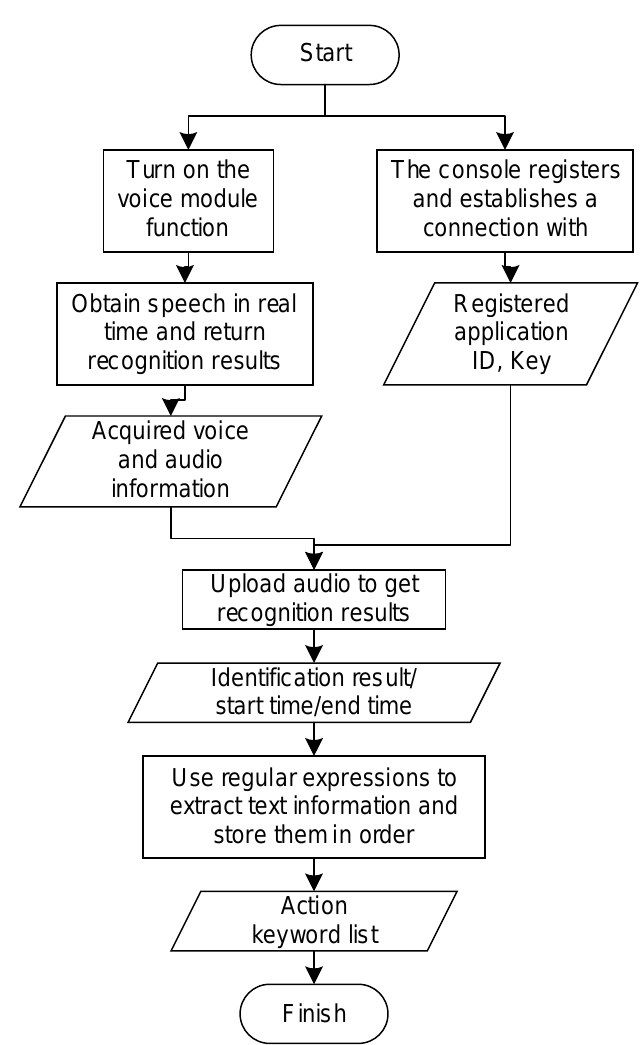
Figure 9. Flow chart of speech recognition and keyword extraction.